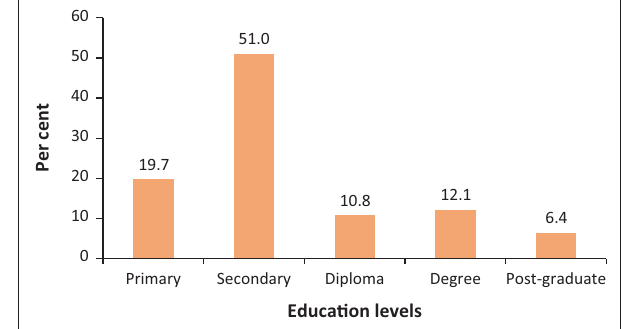
FIGURE 1 : eDumbe locality municipality